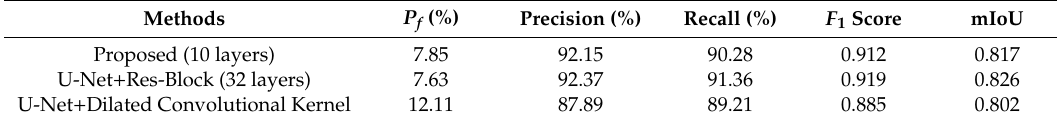
Table 5. Comparison between di ff erent methods based on the